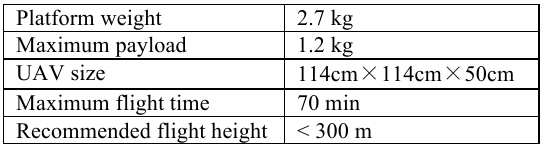
Table 1. Main characteristics of md4-1000.